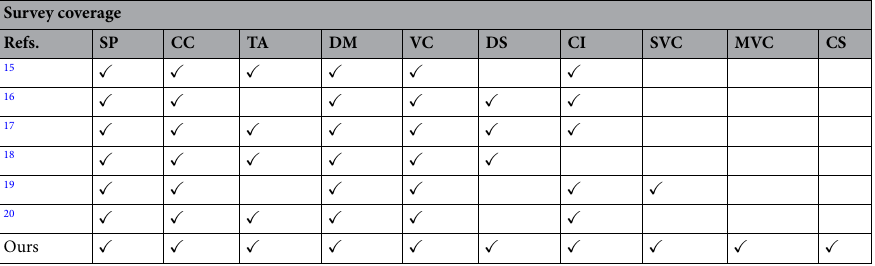
Table 1. Comparison of autonomous vehicle collision (single and multiple vehicles) avoidance related survey papers. SP Sensing & perception, CC Communication & cooperation, TA Threat assessment, DM Decision- making, VC Vehicle control, DS Database & software, CI Challenges and issues, SVCA Single vehicle collision avoidance, MVCA Multiple vehicle collision avoidance, CS Conceptual solution.